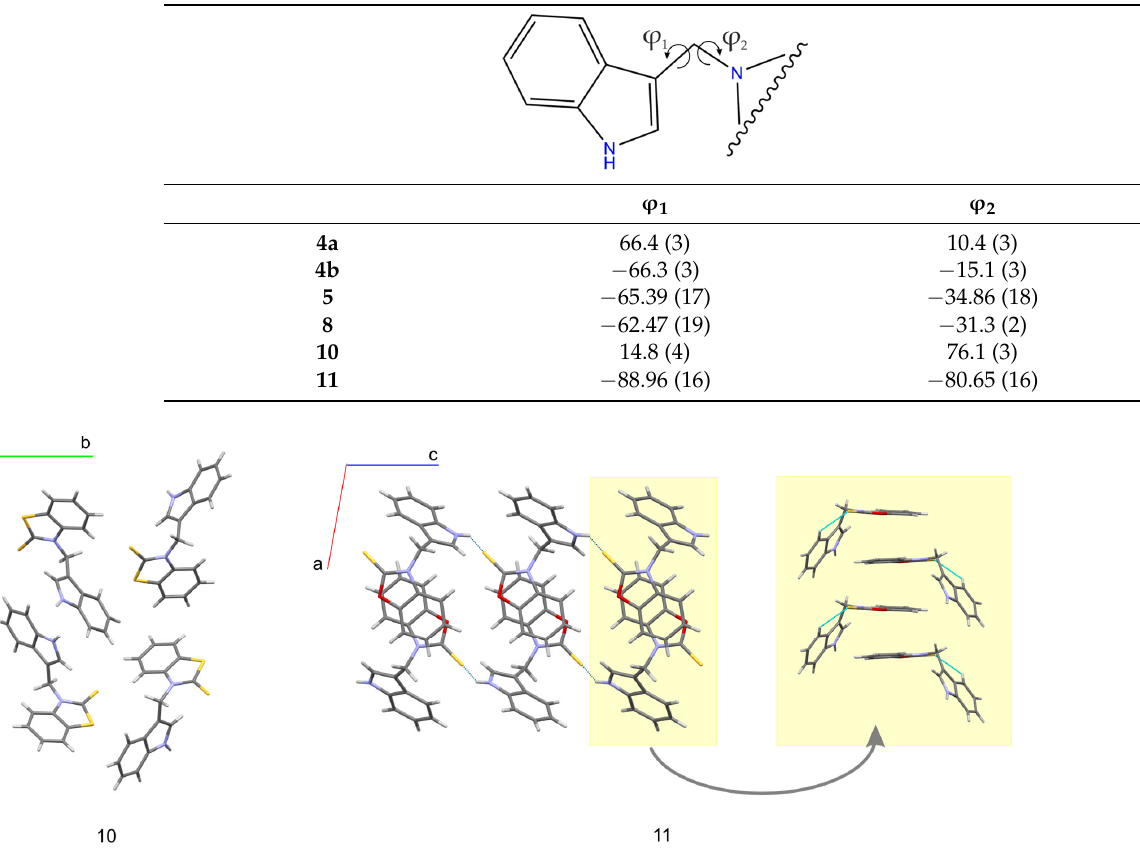
Table 1. Torsion angles ( ◦ ) describing rotation around the methylene C-C and C-N bonds in molecules present in crystals.